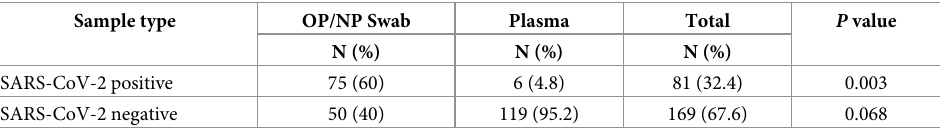
Table 1. Profile of SARS-CoV-2 RNA results based on sample type, analysed on BGI RT-qPCR molecular